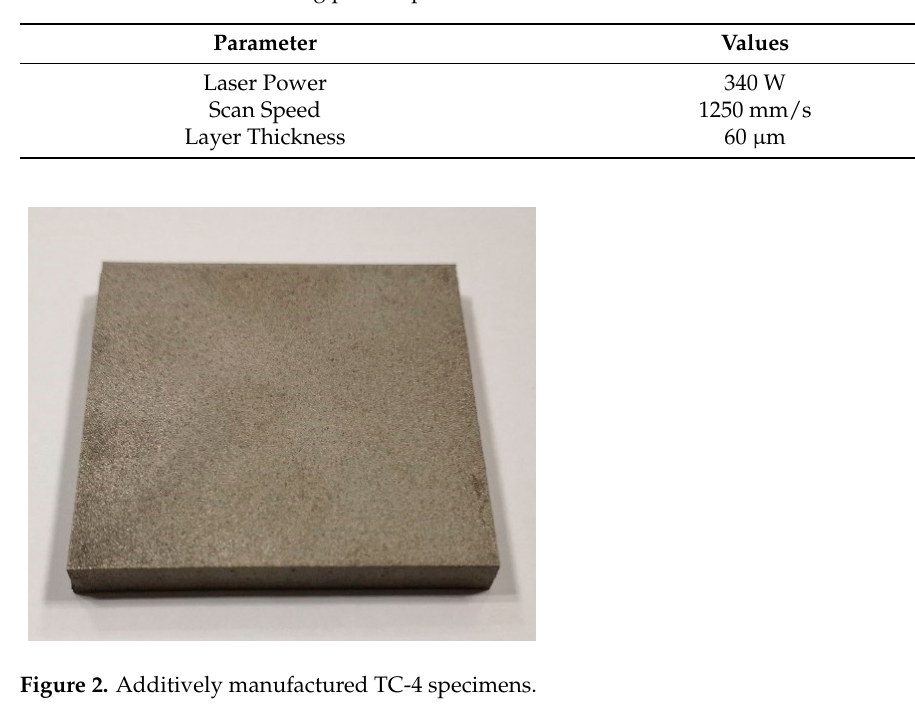
Figure 1. In-house selective laser melting equipment LAS300 with fiber laser. Table 2. Selective laser melting process parameters.